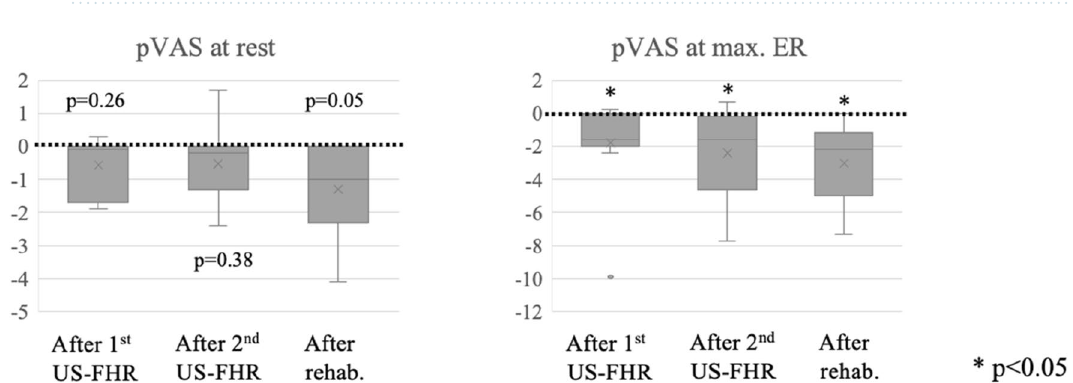
Figure 1. Box-and-whisker plot of ROM change over time compared to baseline. The vertical line is the measure of degree. Abbreviations: Abd, abduction; ER, external rotation; Ext, extension; Flex, flexion; IR, internal rotation; pROM, passive range of motion; rehab, rehabilitation; US-FHR, ultrasound-guided fascia hydrorelease. Note: dot lines indicate the baseline.